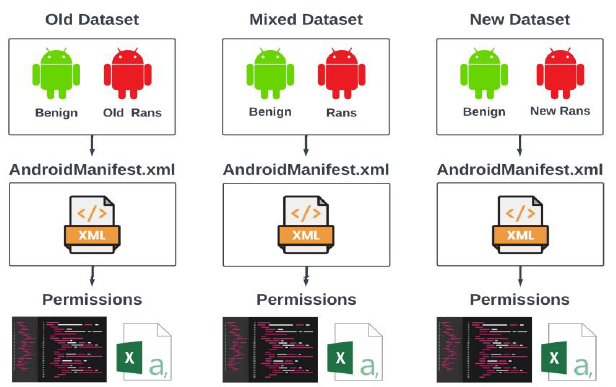
Figure 4. The methodology of creating the